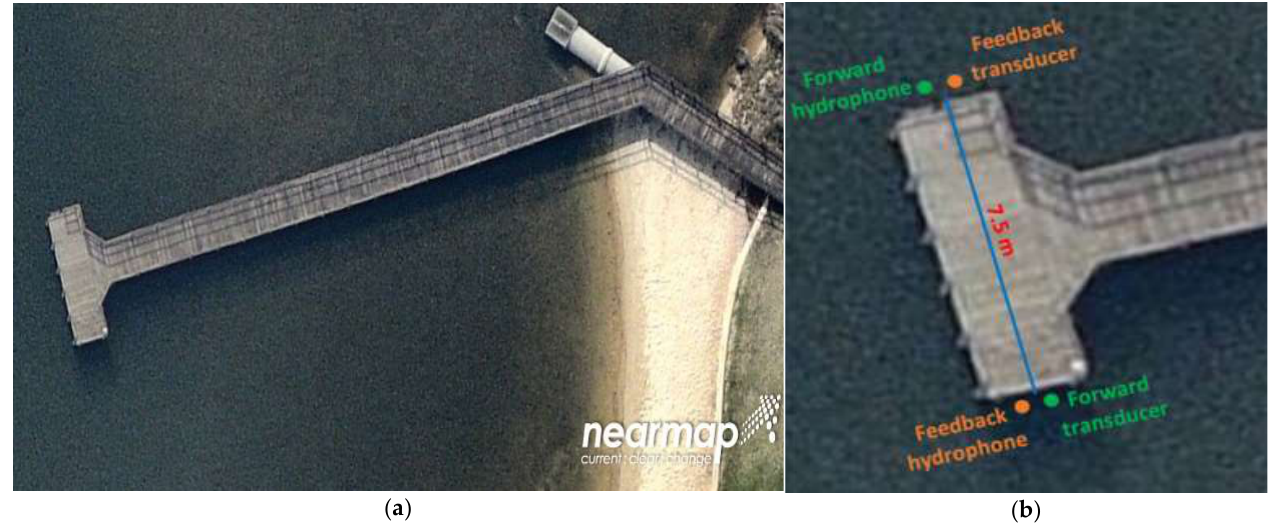
Figure 14. ( a ) The jetty in the Canning River where the real-time river experiment was carried out. ( b ) Location of the transducers and hydrophones in the river experiment for the cluster-based adaptive modulation.